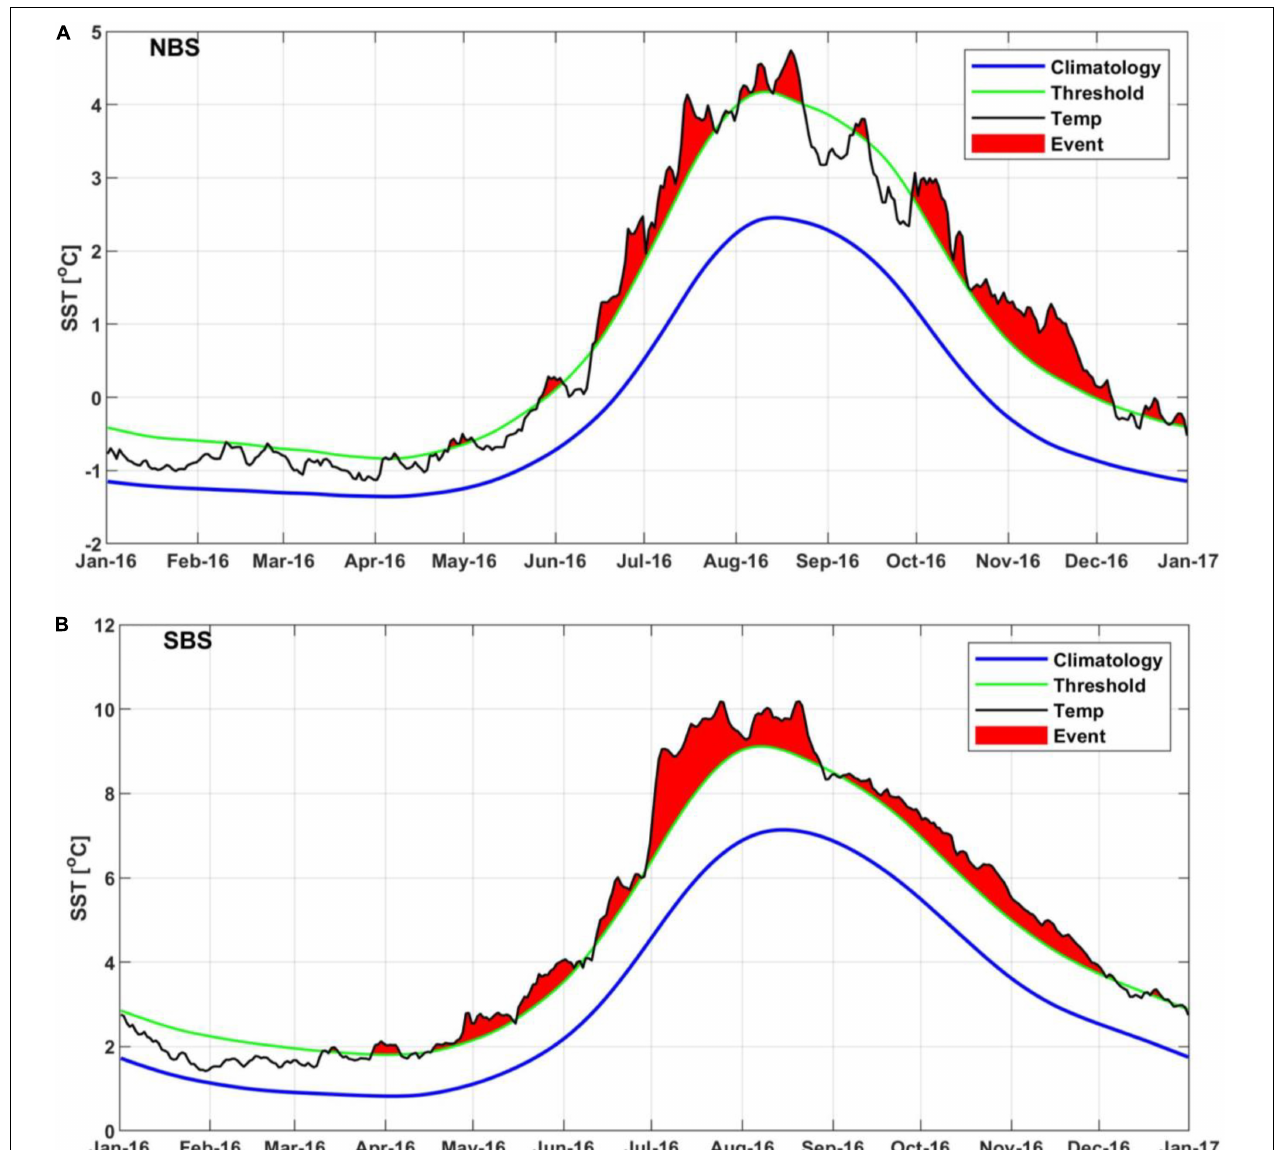
FIGURE 8 | Evolution of the daily SST time series within (A) the northern Barents Sea (NBS), and (B) the southern Barents Sea (SBS) from January to December 2016 (black lines). The blue line represents the daily climatology over a 39-years period (1982–2020). The green line represents the seasonally varying 90th percentile threshold. Red shaded regions indicate the period associated with the identified MHWs. The y -axes for the two plots are different to increase visibility, as the SST varies greatly from NBS to